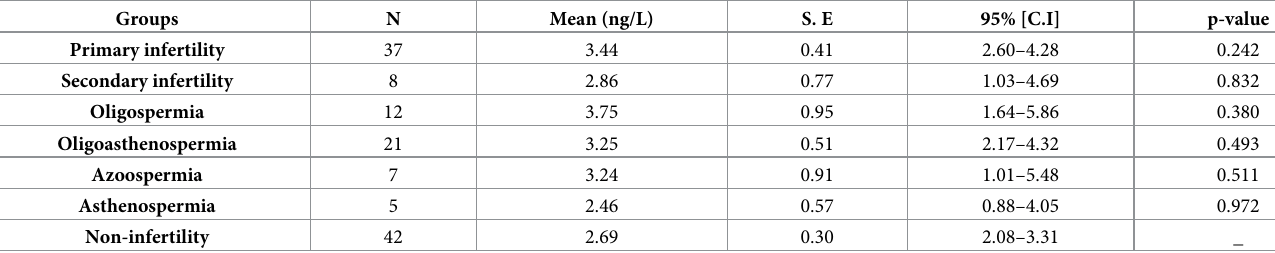
Table 6. Status of TNF- α in different types of male